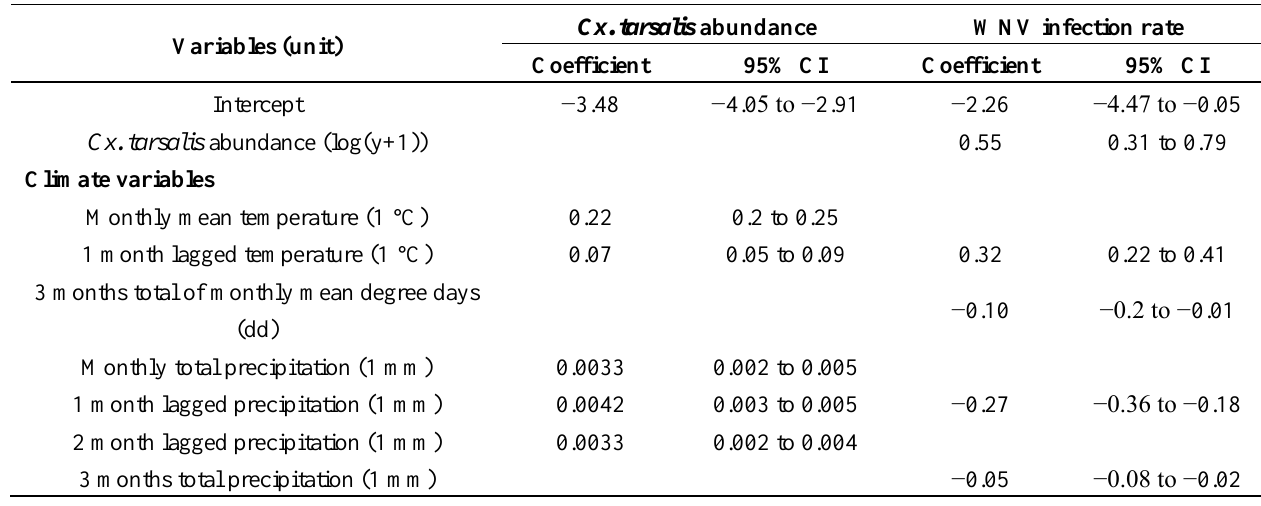
Table 2. Coefficients of variables in the final models of Cx. tarsalis abundance and WNV infection